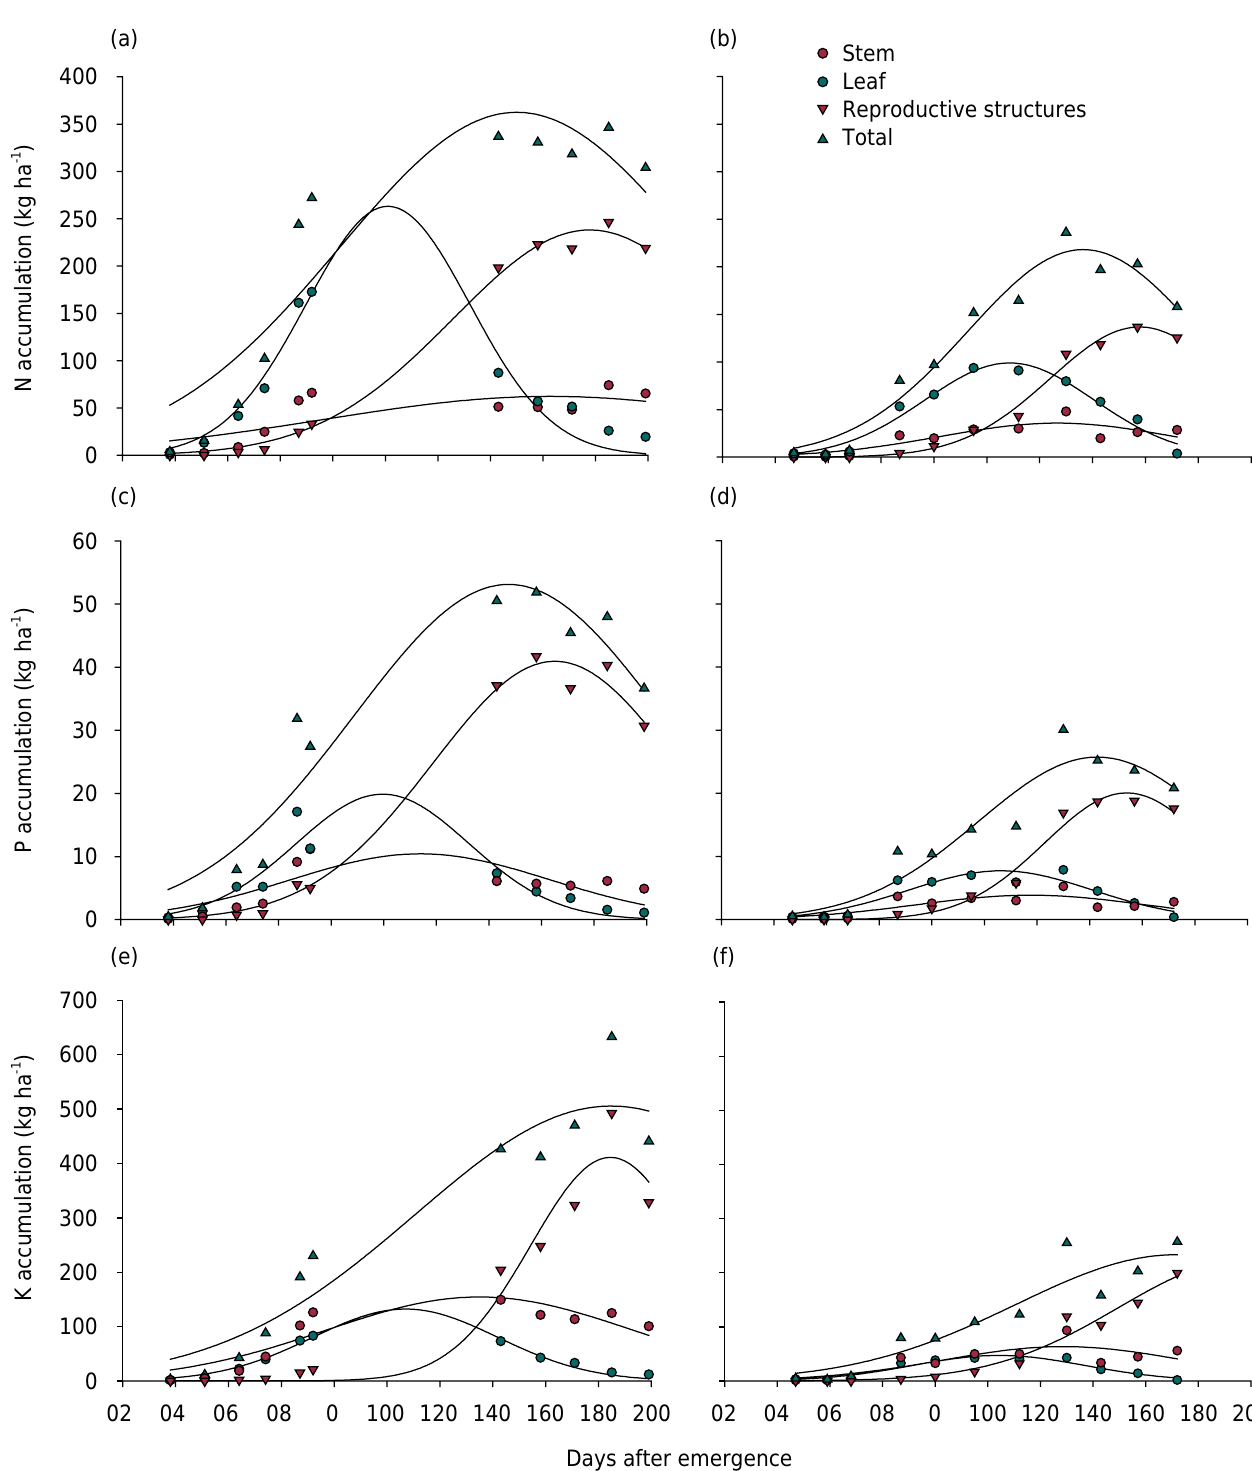
Figure 3. Nitrogen, P, and K accumulation by cotton at the study sites in the states of Bahia (a, c, e) and Mato Grosso (b, d, f), Brazil. Results represent the average of three varieties in Bahia and two varieties in Mato